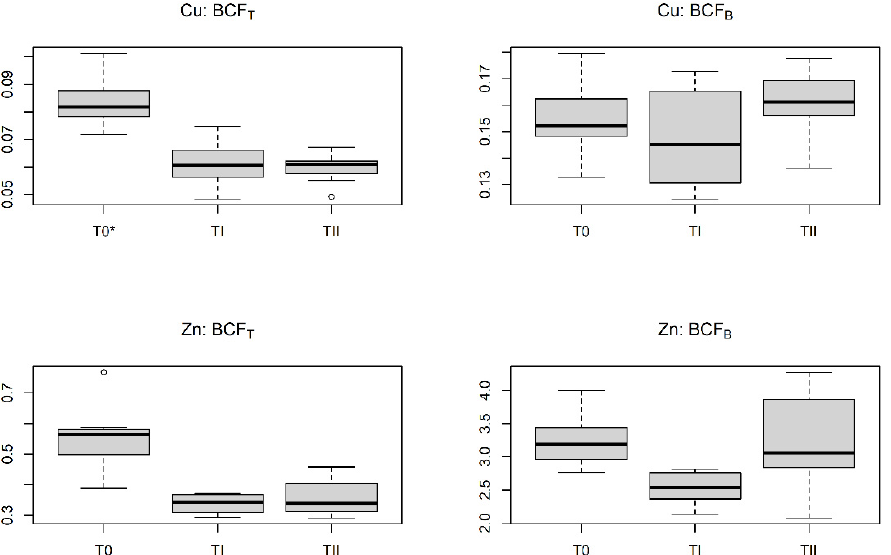
Figure 8. Bioconcentration factors for total (BCF T ) and bioavailable amounts (BCF B ) calculated for Cu and Zn in oat; * for descriptions see Material and Methods. Statistically significant differences and p -value are presented in Table 3.